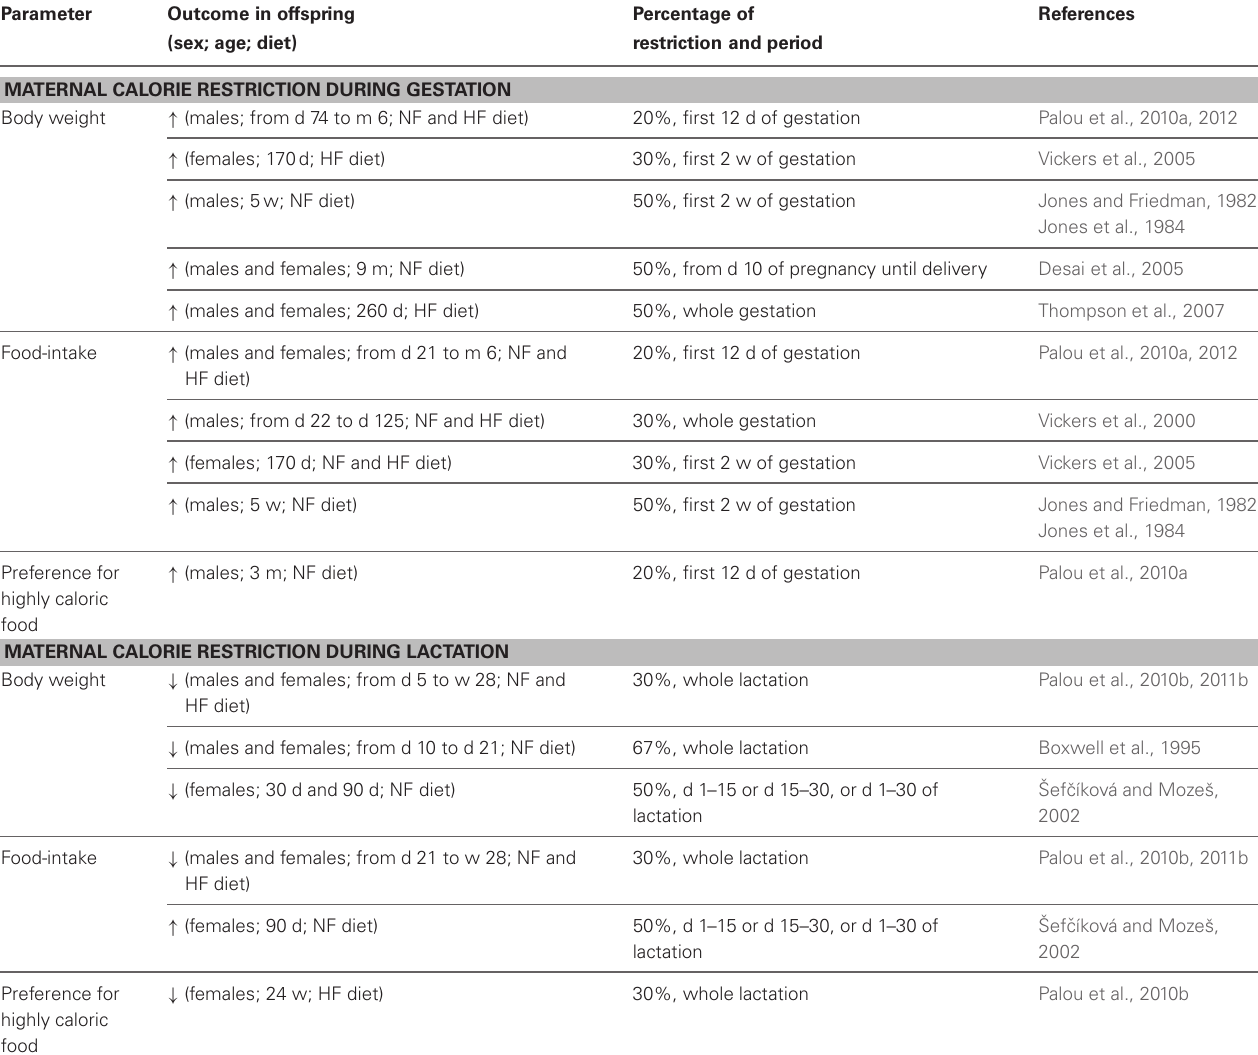
Table 1 | Impact of different percentages of calorie restriction during gestation or lactation on male and female